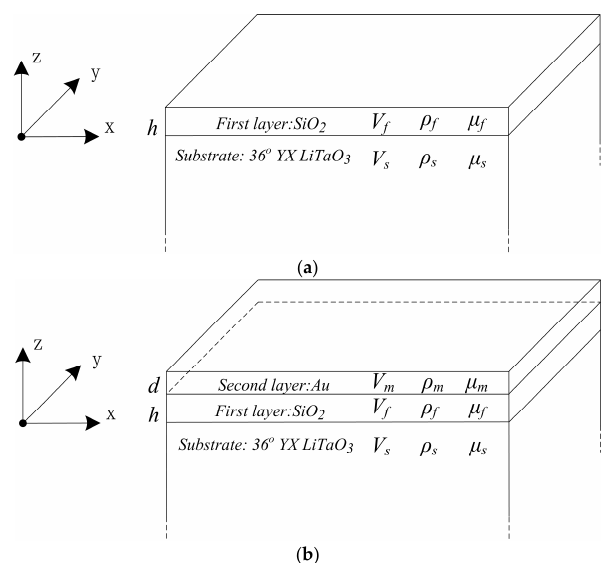
Figure 1. Diagram of the Love wave sensor: ( a ) monolayer; ( b ) double-layer. The x -axis is the longitudinal direction that the Love wave is propagating along; the y -axis is the shear horizontal direction of the particle vibration; and the z -axis is the normal direction of the device surface. Because the particle displacement is shear horizontally polarized, the piezoelectric substrate can be simplified as an isotropic or highly symmetrical anisotropic material.